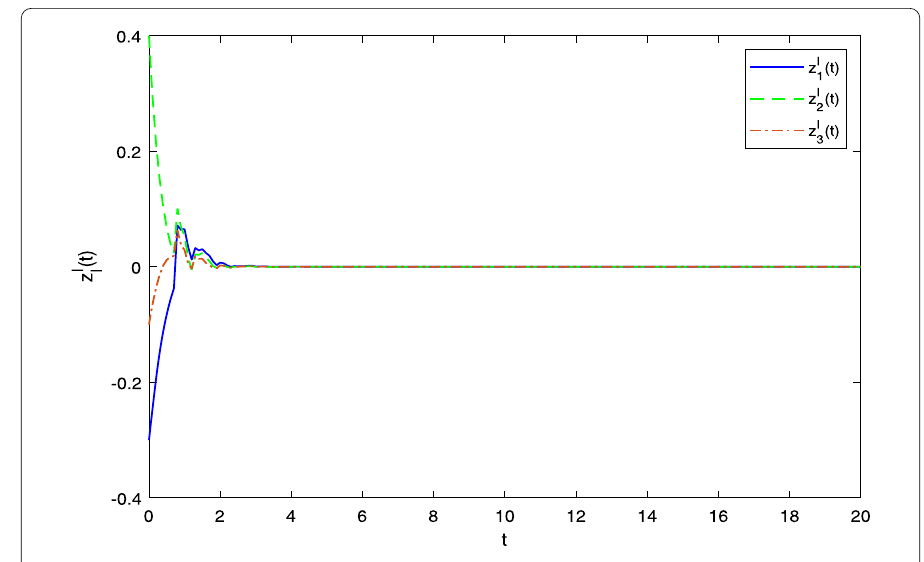
Figure 4 State trajectories of variables z I